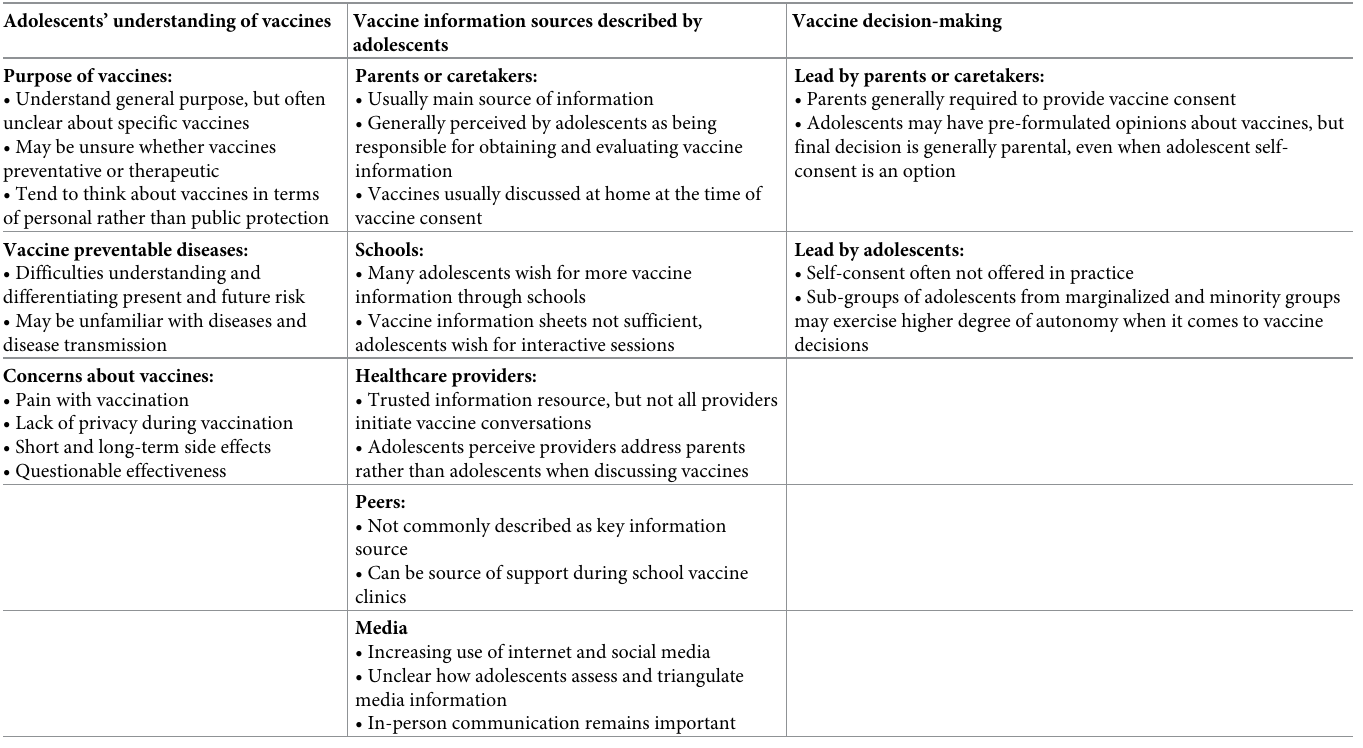
Table 2. Summary of qualitative